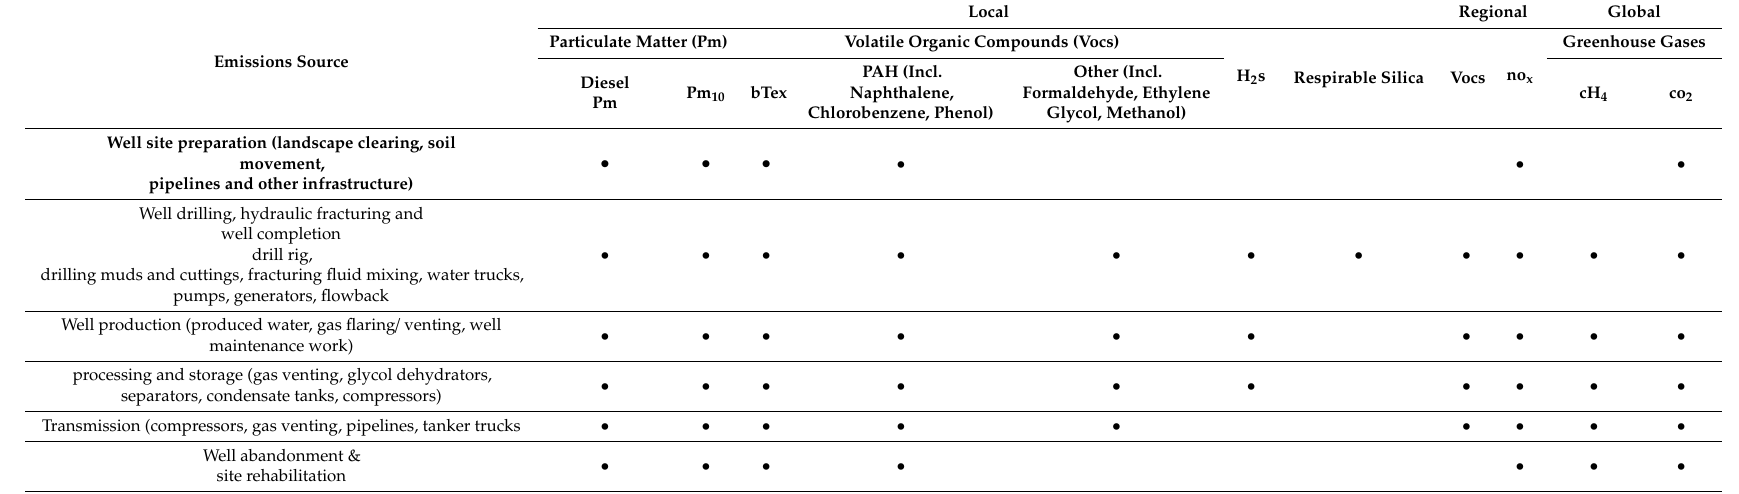
Table 2. Characterisation of the main sources of air pollution from oil and gas development according to well process stage [22]. Source NRDC. Used with permission.